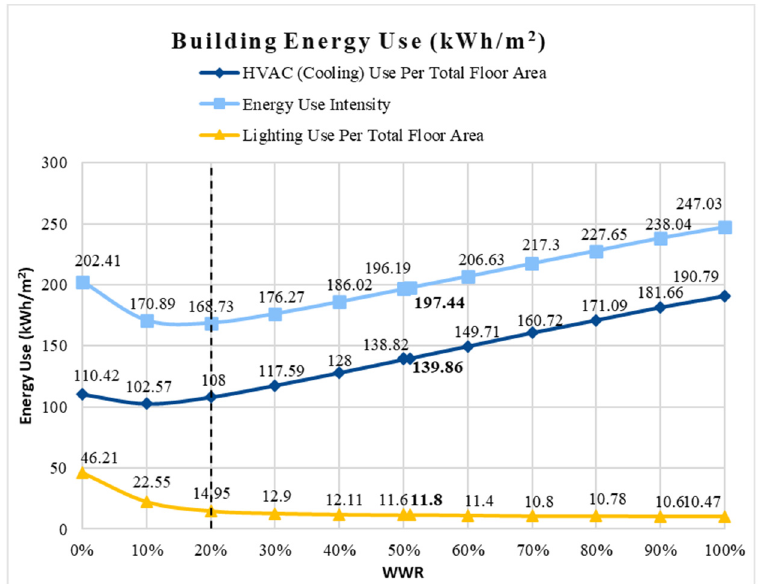
Figure 6. Effect of west façade WWR on building energy use per total floor area (baseline simulation values highlighted in bold).